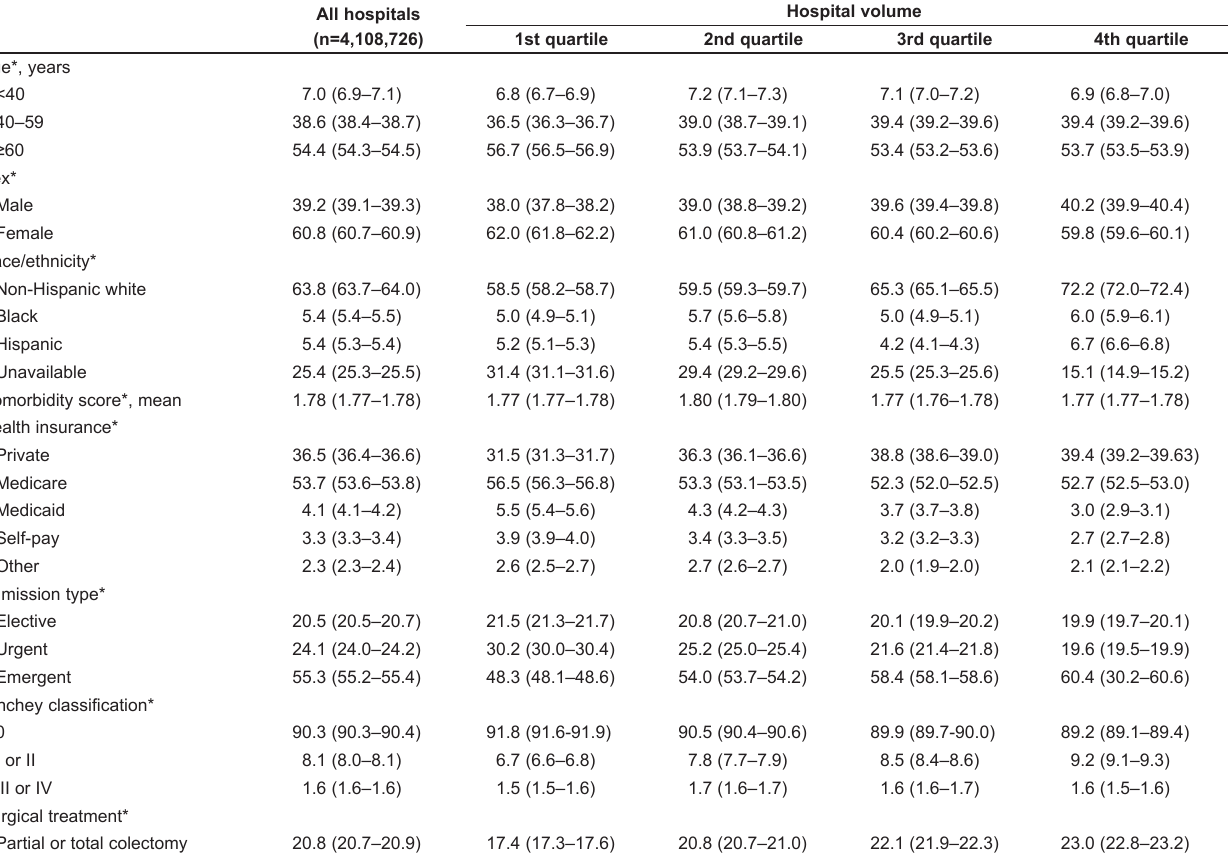
TABLE 1 Characteristics of patients admitted for diverticulitis between 1993 and 2008, according to hospital volume quartile